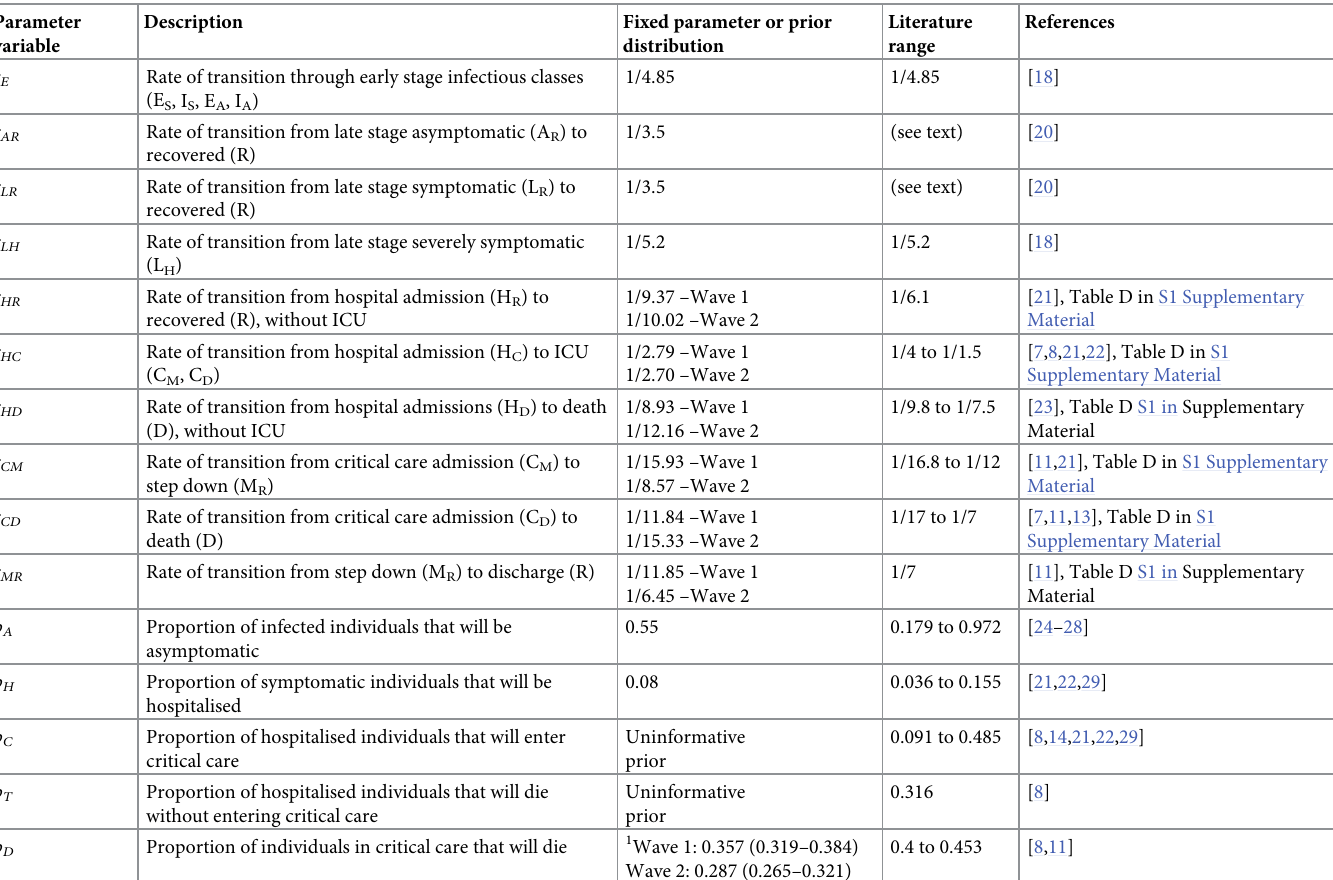
Table 3. Parameter variables and values for the compartmental